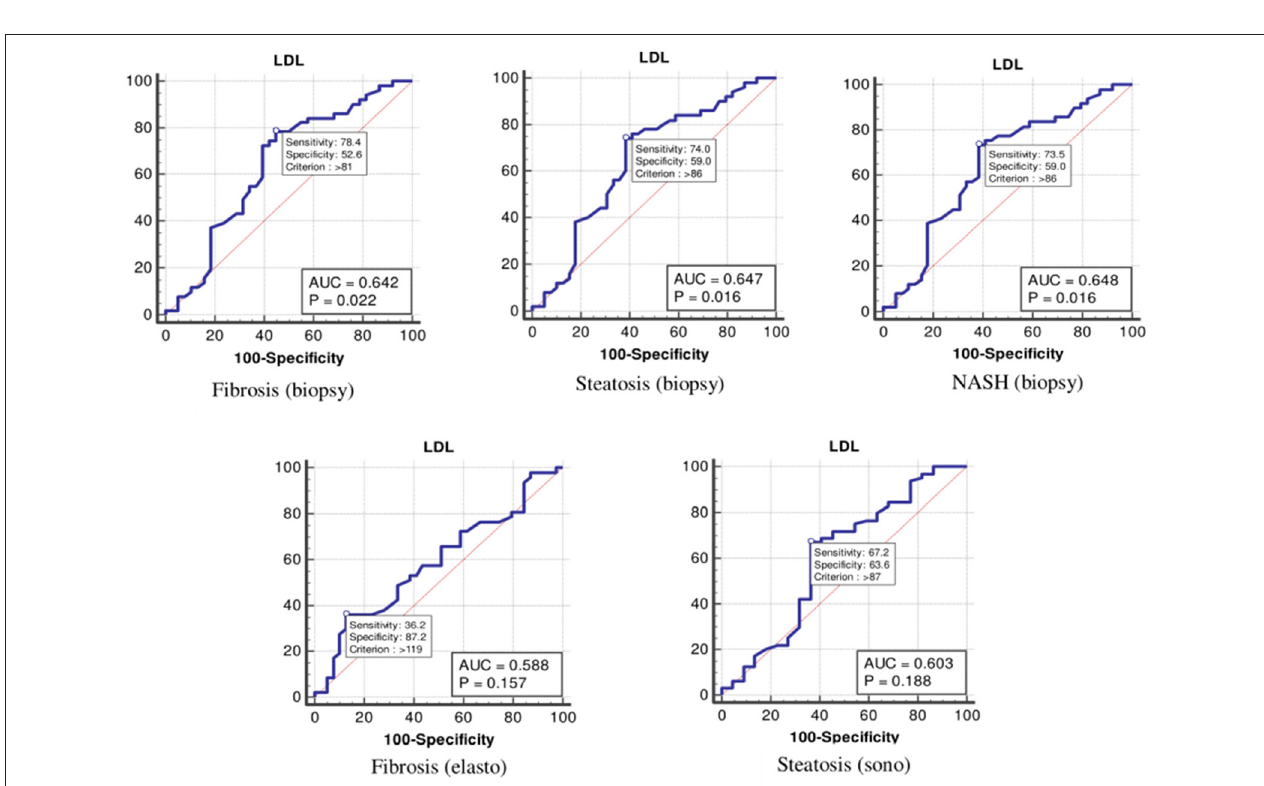
FIGURE 2 | The receiver operating characteristics curve for low-density lipoprotein cholesterol in the detection of liver disease.